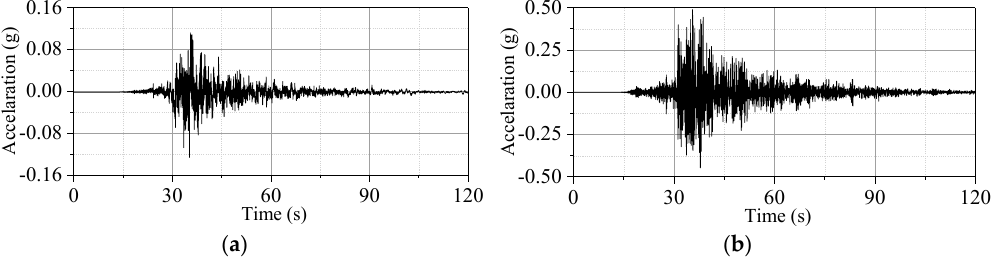
Figure 8. TKCH 080 acceleration time history records: ( a ) bedrock; ( b ) ground surface.